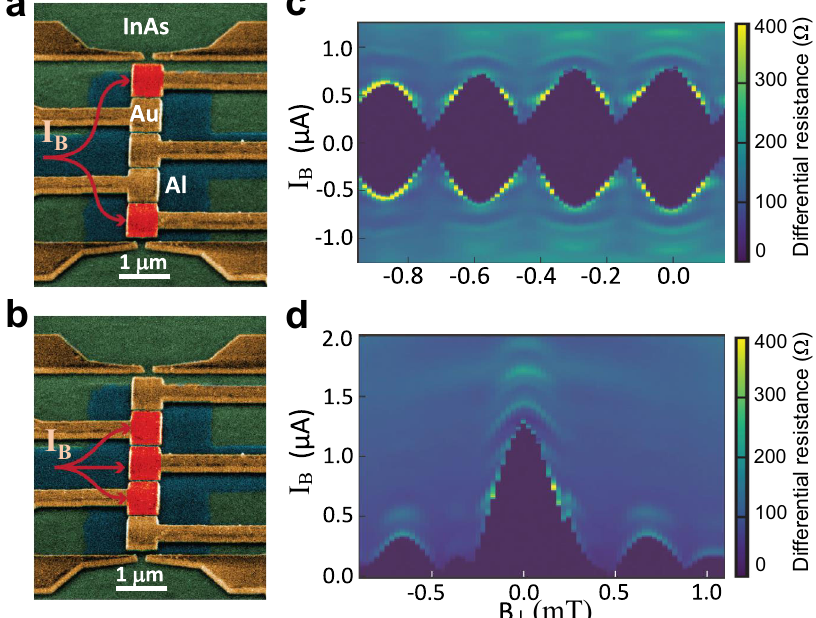
Fig. 3 Experimental mini-gate control in an SJ. a , b Scanning electron microscope (SEM) image of an InAs/Al SJ with fi ve mini gates covering the normal region. Mini gates can be controlled independently and those overlaid in red indicate the regions in which the applied bias current, I B can fl ow. The 2DEG is depleted under the other gates. c , d Differential resistance of the device as a function of the I B and out-of-plane B ⊥ , corresponding to the gate con fi guration presented in a , b , respectively.